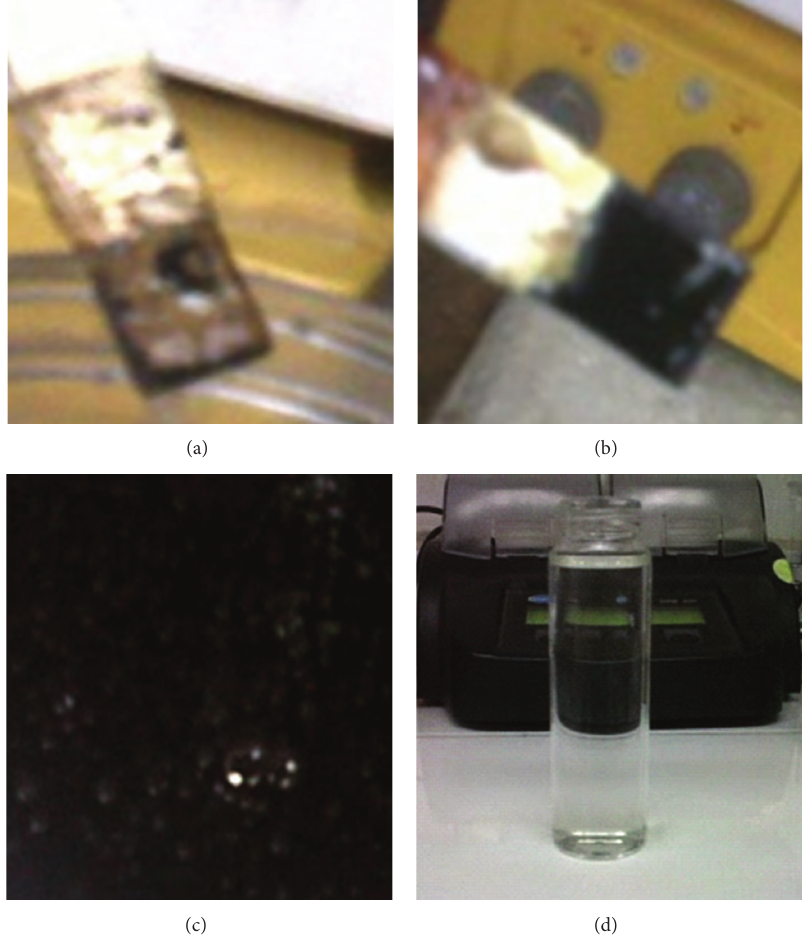
Figure 9: Electrochemical treatment of spent caustics mixture. (a) Applying a current where the ∙ OHs are not generated. (b) Applying a current where the ∙ OHs are generated. (c) Electrolyzed sample (without pretreatment). (d) Sample obtained after the electrochemical treatment with Ti/BDD applying 0.96 A ( 𝑗 = 0.32 Acm −2 ), under constant stirring, pH 1 (adjustment with H 2 SO 4 ) and 𝑡 𝑟 = 15